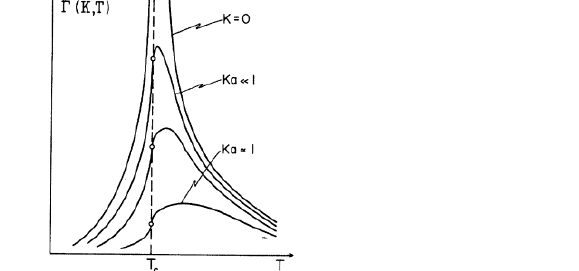
Fig. 3. Qualitative behaviour of the spin-correlation Γ as a function of the reciprocal vector K and temperature T [12], the singularity or the maximum is mainly contributed by the short-rang spin